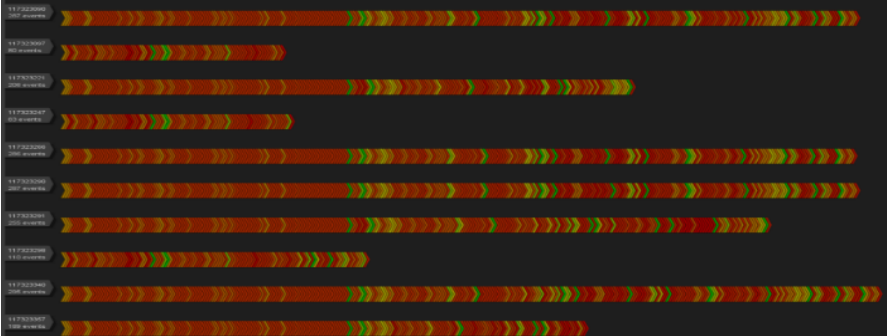
Figure 8. Sample task list with unique identifier and events-Explorer view ProM tool.